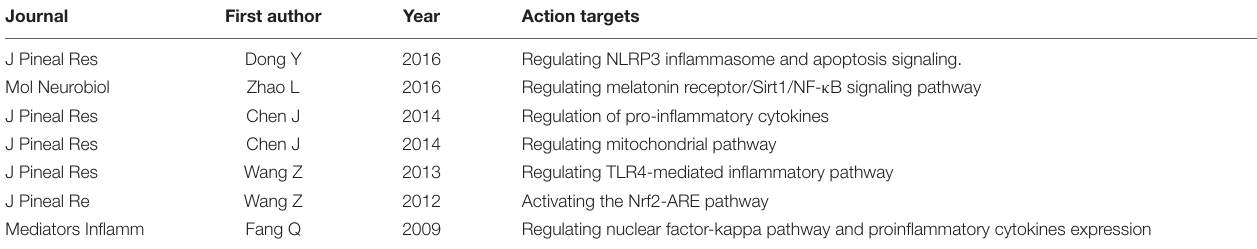
TABLE 1 | Functions of melatonin in improving brain injury after subarachnoid hemorrhage.